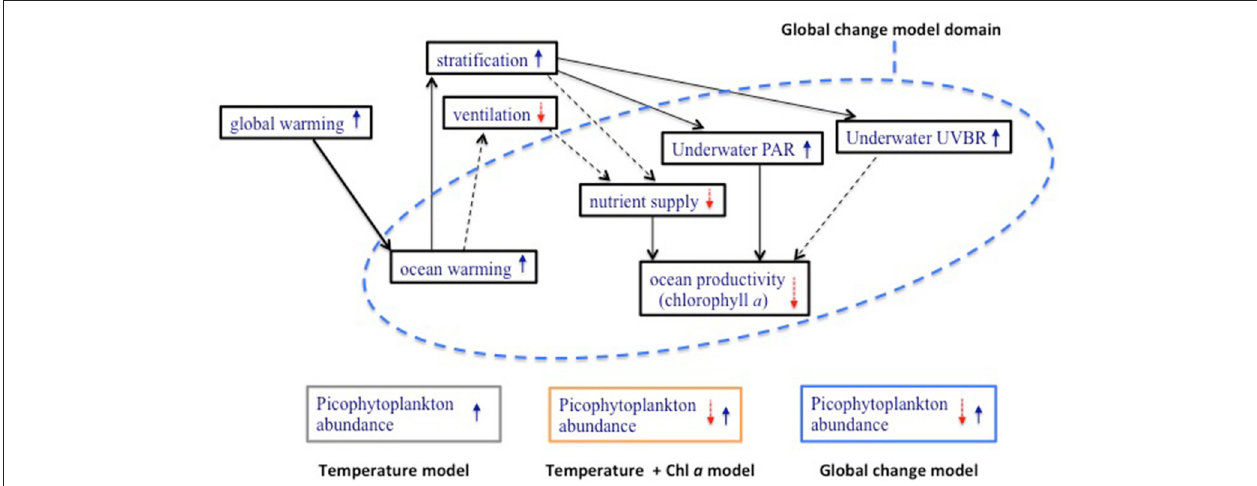
FIGURE 1 | A conceptual model, modified after Tyrrell (2011), of the effect of ocean warming on key ocean properties affecting primary producers (blue text inside black boxes). Solid arrows indicate a positive influence and an increase in the value of the property, and broken arrows indicate a negative influence and a decrease in the property. Upward blue and downward red arrows within a box indicate an increase and a decrease in the property, respectively. The diagram identifies the processes considered by a model based on the direct thermal effects on the organisms (gray box), those included in a model considering increased temperature and changes in productivity due to oligotrophication with ocean warming (yellow box), and a global-change model considering multiple relevant processes and interactions affected by warming (blue box). The presence of both upward and downward arrows within a box indicates that the responses involve positive and negative effects due to complex interactions that render predictions